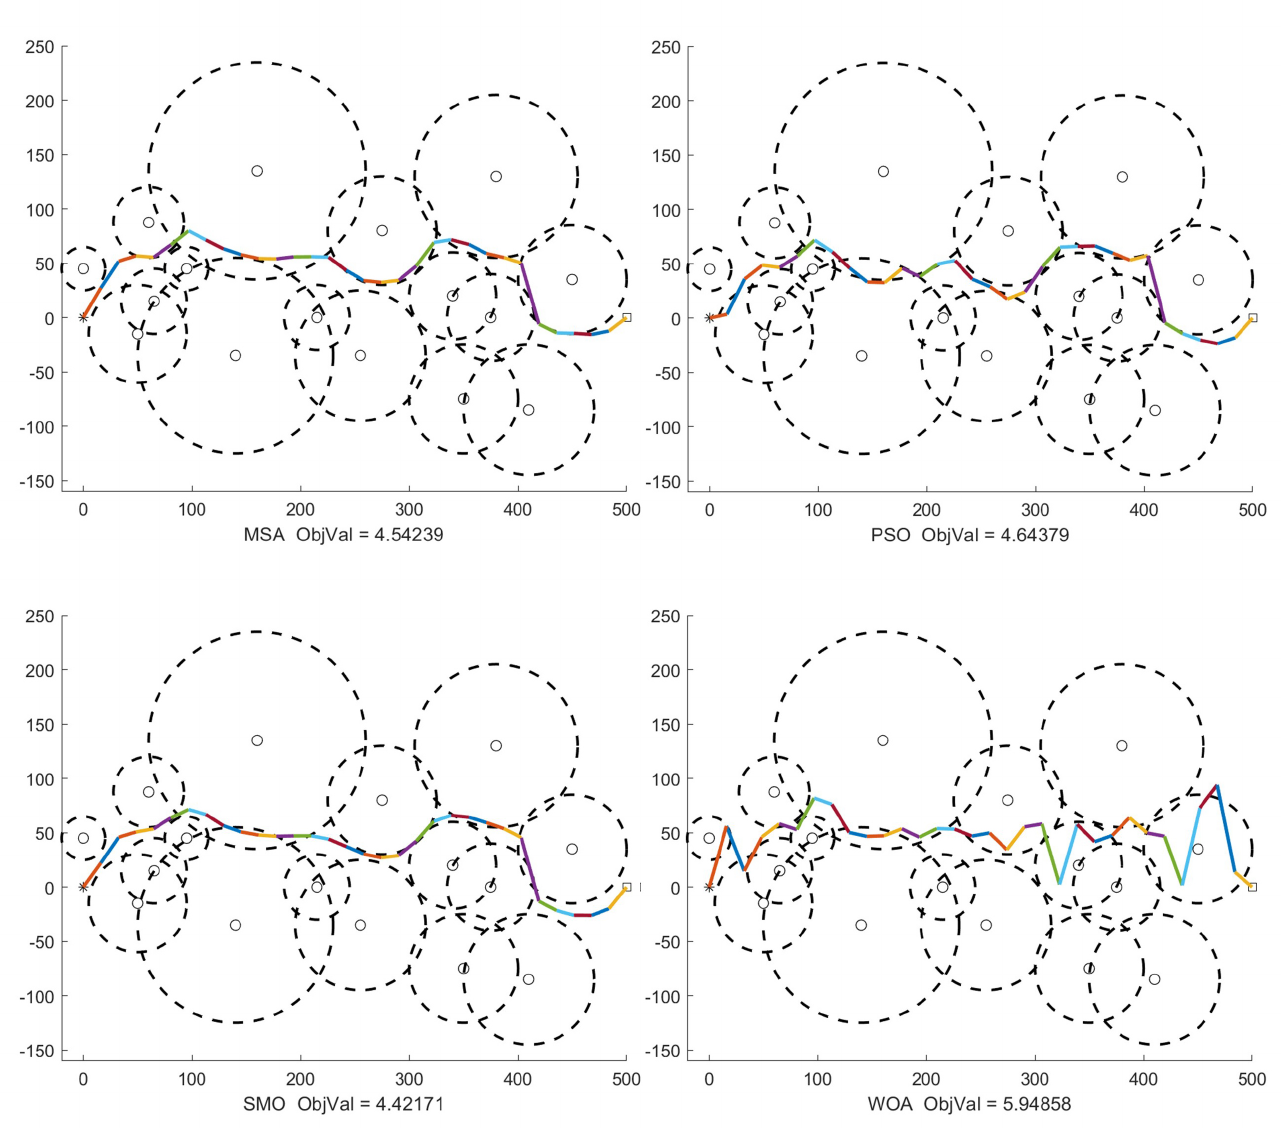
Figure 8. The comparison performance of different swarm intelligence algorithms including MSA, PSO, SMO and WOA for Case 8 with D = 30, N =